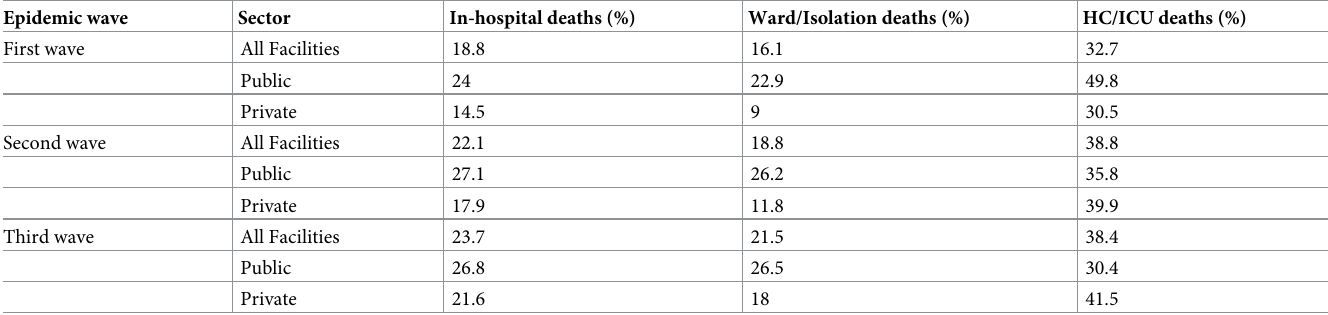
Table 3. In-hospital deaths in public and private